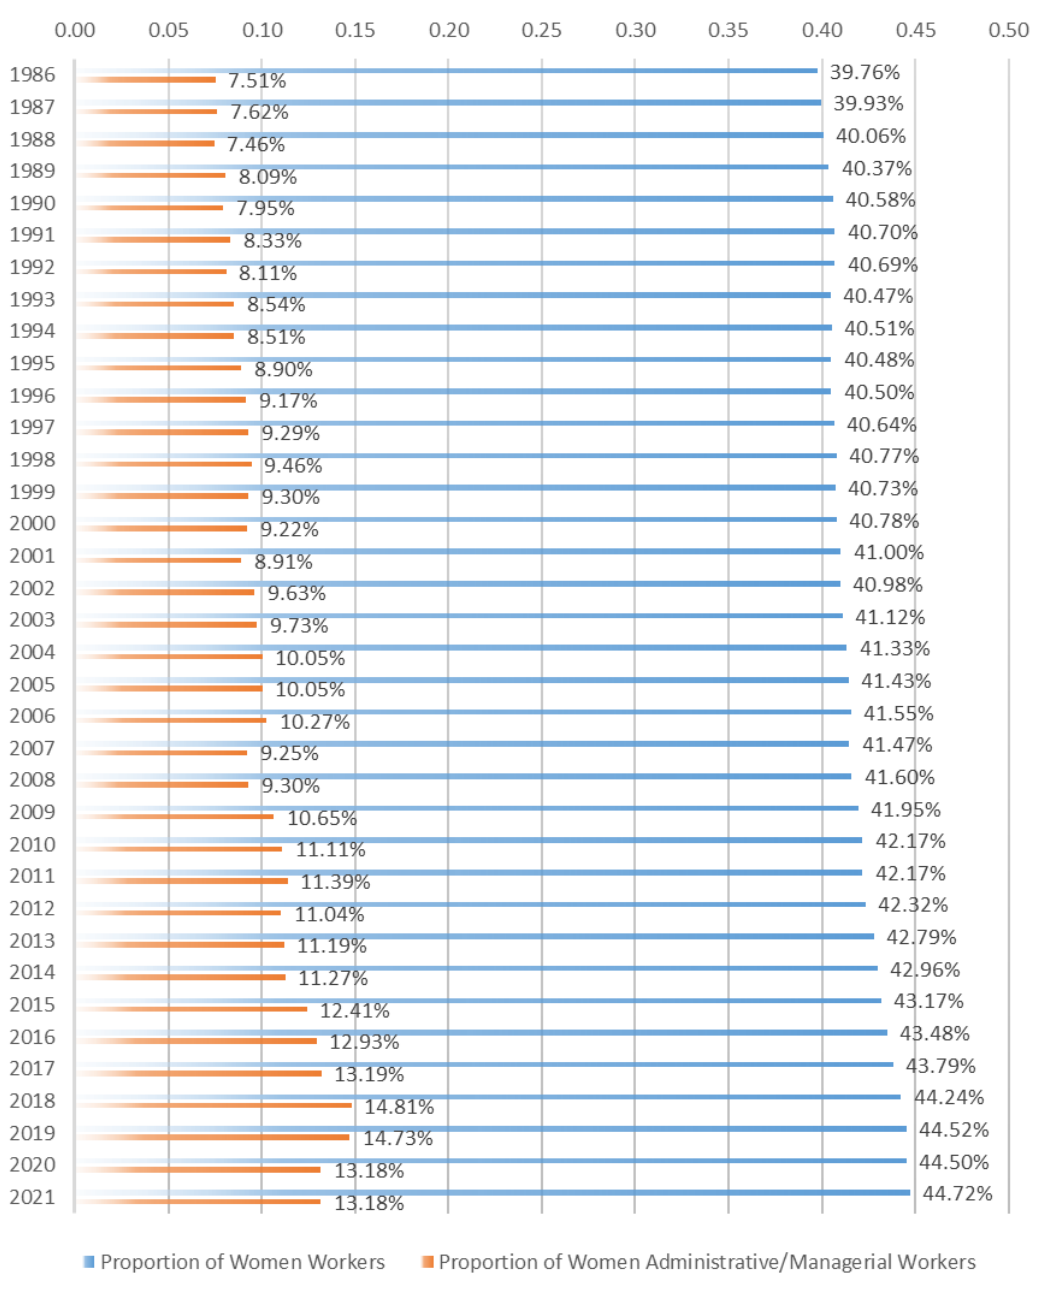
Figure 5. Proportion of Women Workers and Women Administrative/ Managerial Workers